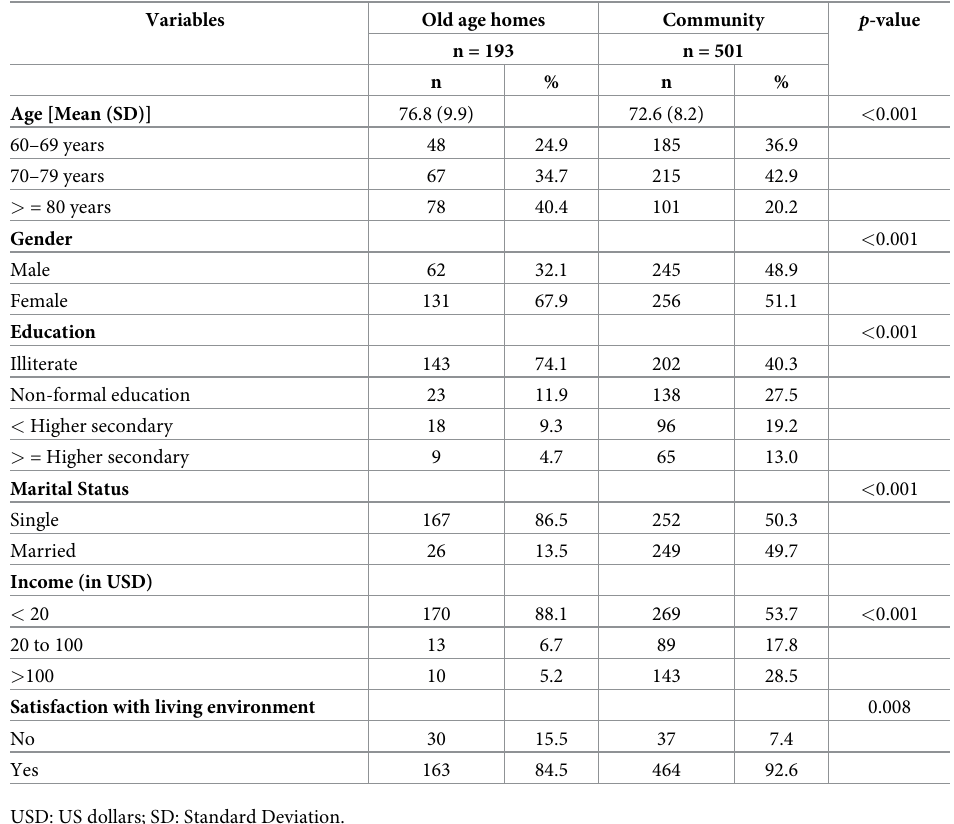
Table 1. Sociodemographic characteristics. Variables Old age homes